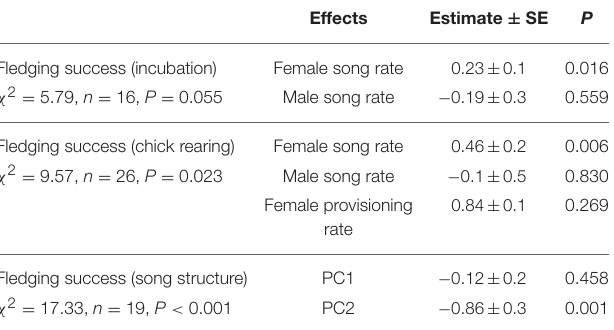
associated with PC2 ( Table 2 ; Figure 7 ). Hence, the more syllable types and syllable transitions in a female’s song, the greater number of chick fledged ( Figure 8 ). The duration of the song, the total number of syllables, and the number of introductory stutter syllables did not predict nesting